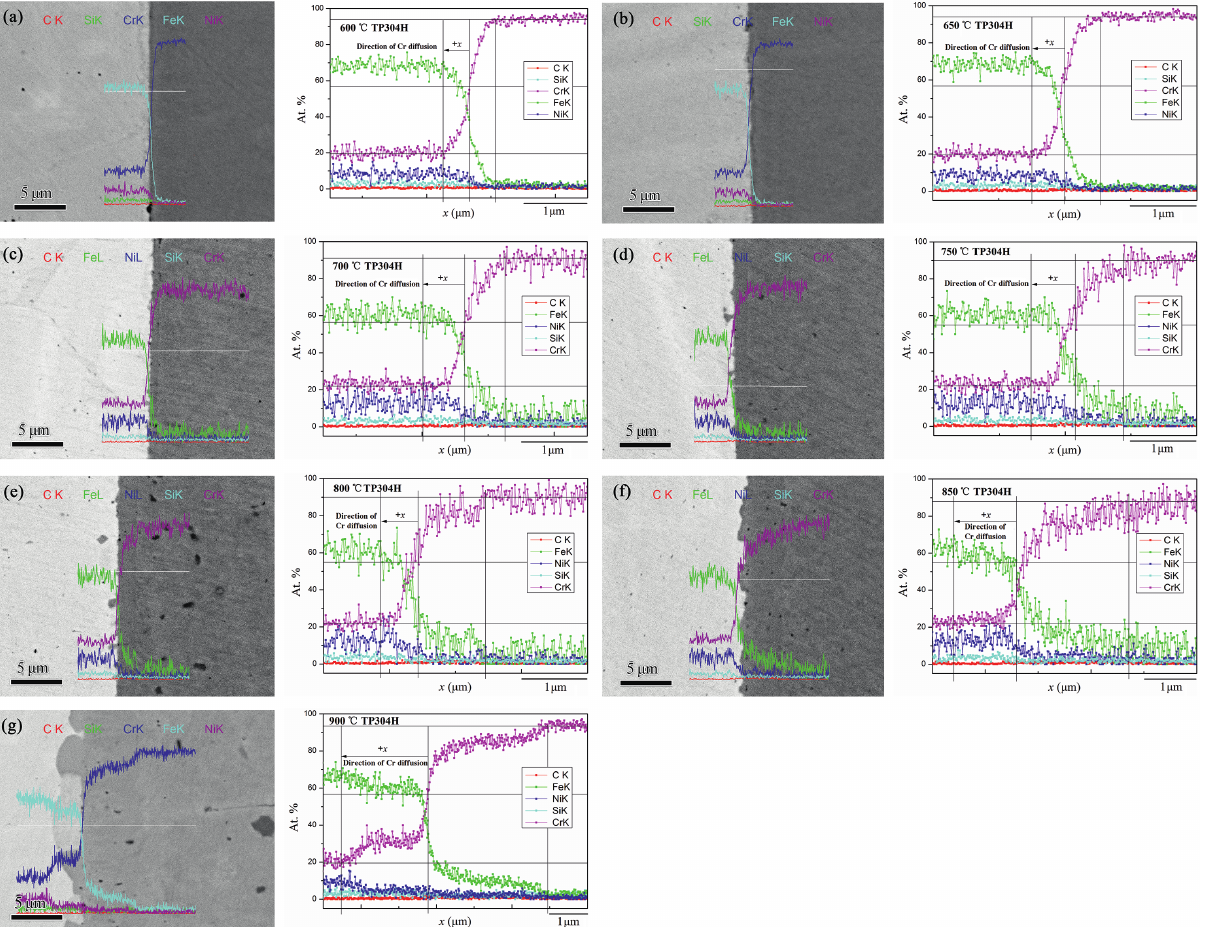
Figure 4: Left: Quantitative line scan spectrum across the bonding interface of TP304H diffusion couples after vacuum heat treatment at different temperatures for 50 h; Right: Corresponding Cr diffusion profiles (in at.%) across the bonding interface (a) 600 ℃ ; (b) 650 ℃ ;